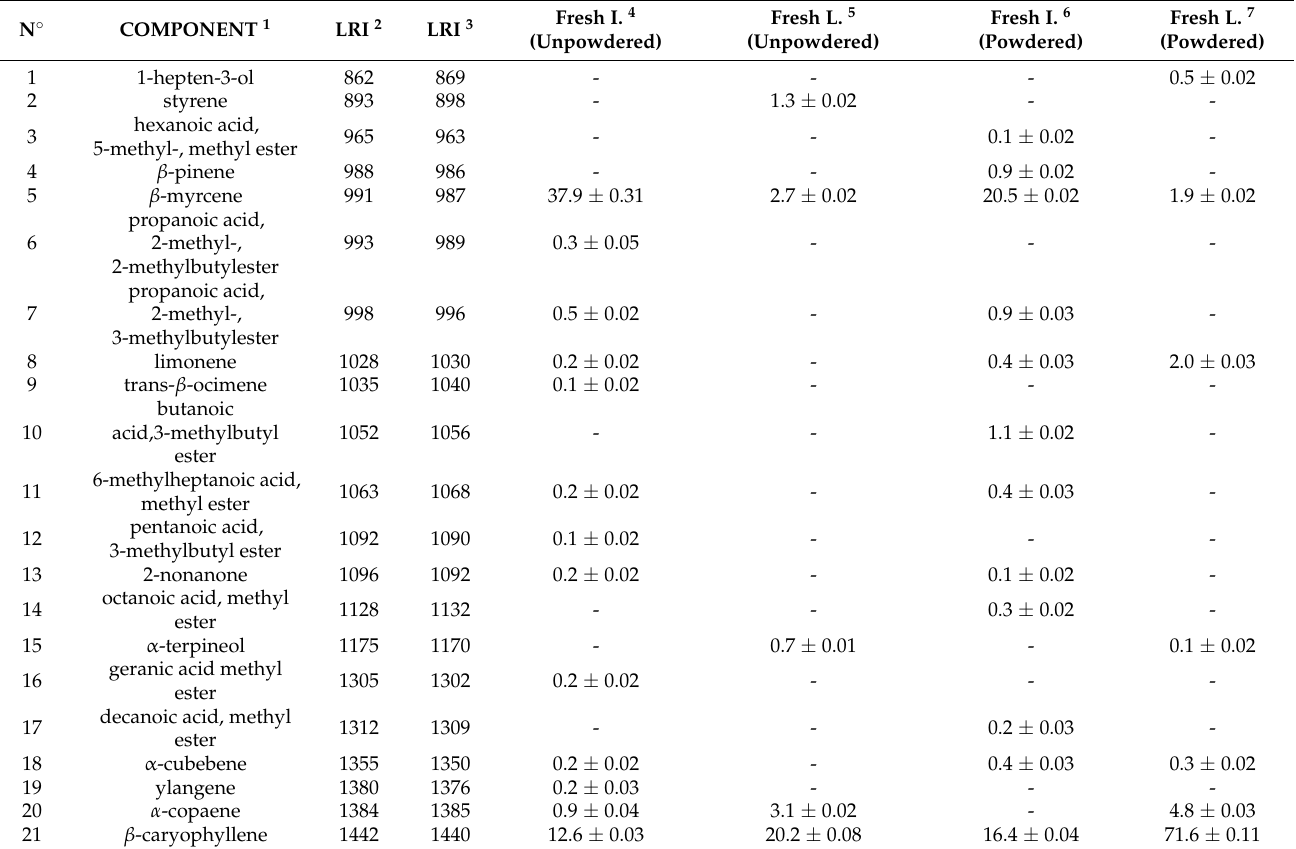
Table 1. Chemical volatile composition (percentage mean value ± standard deviation) of fresh hops inflorescences and leaves (unpowdered and powdered), as determined by